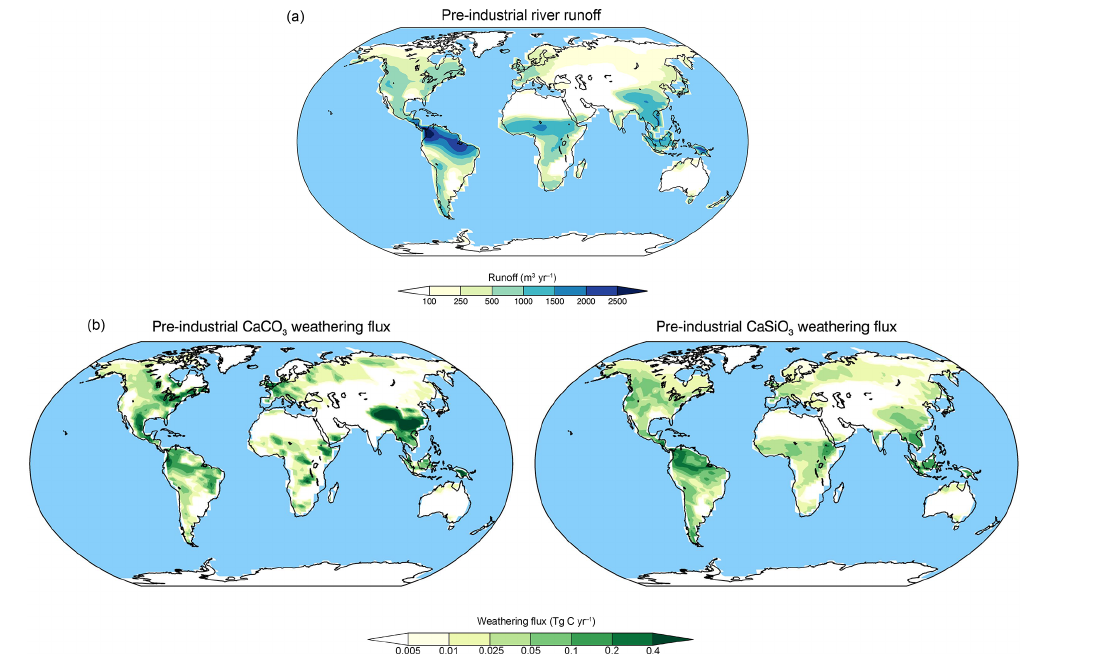
Figure 2. Pre-industrial (year 1800CE) setup for our weathering scheme. (a) Model-simulated annual mean river runoff, which is combined with rock type fractions (see Fig. 1) using Eqs. (4) and (5) to produce (b) the carbonate and silicate weathering fluxes at pre-industrial steady state. Note the nonlinear color scales, used here to better display values outside of tropical